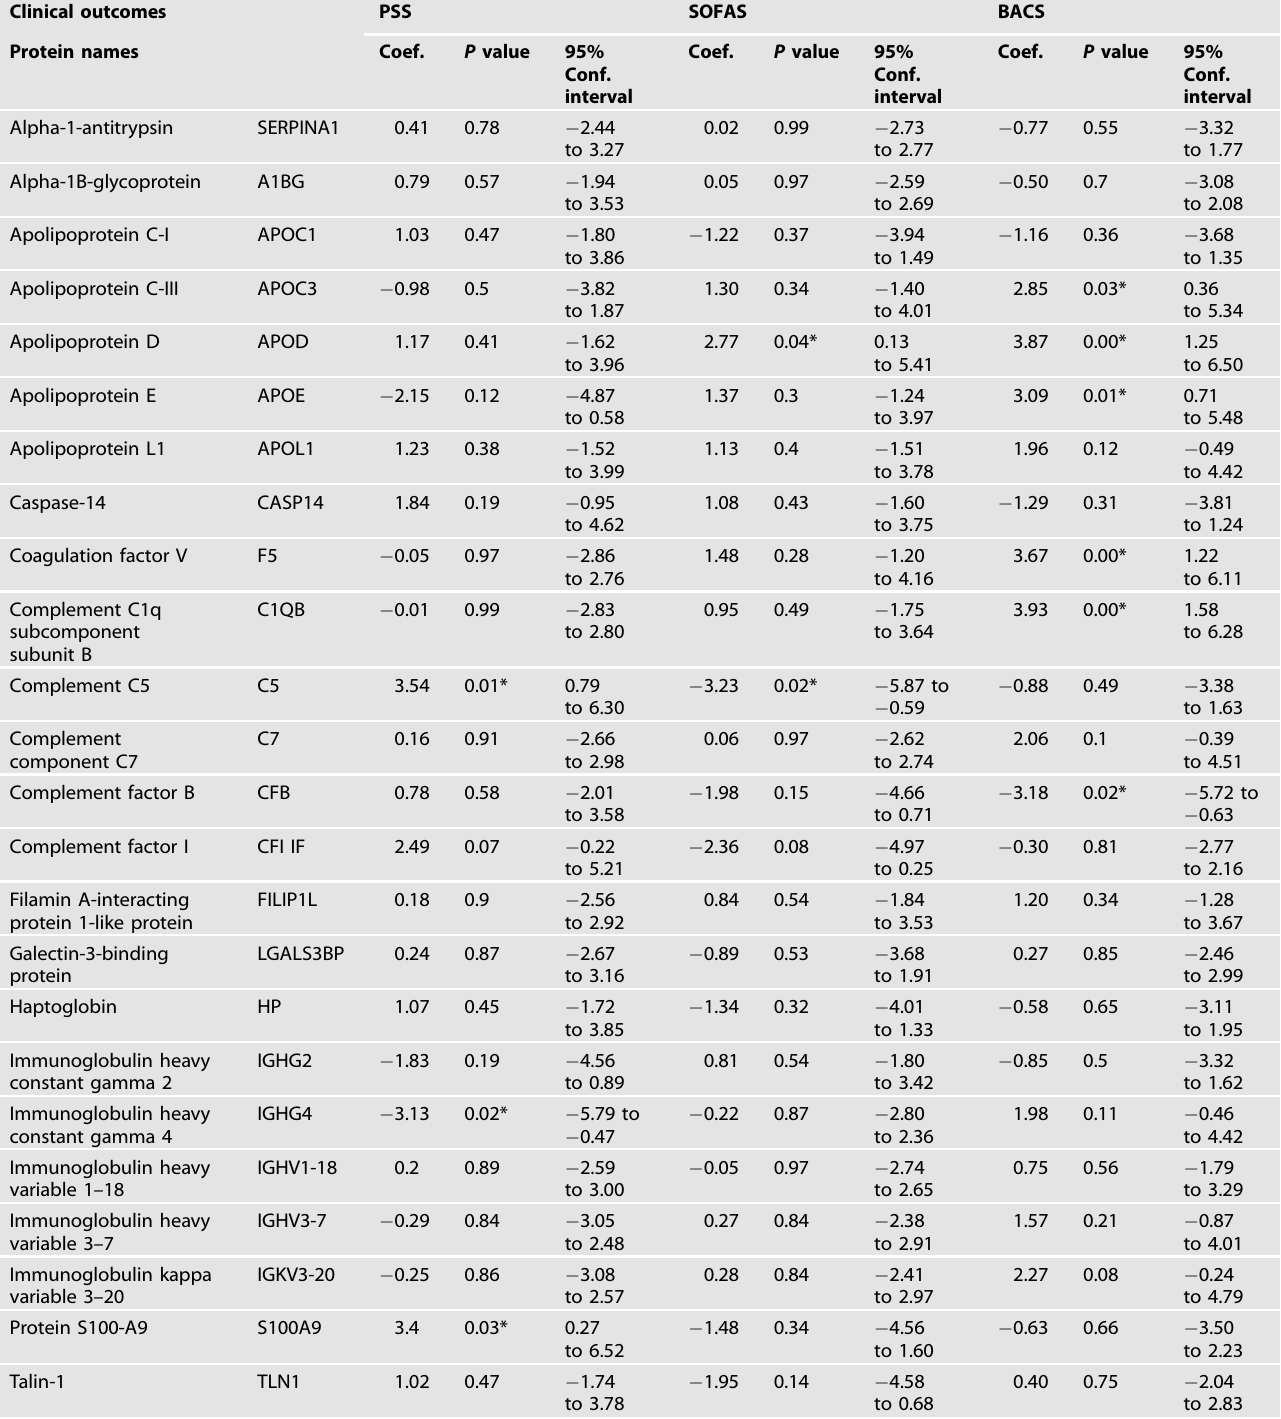
Table 3. Results of linear regression model II, showing a relationship between plasma proteins (which were showing an association with change in omega-3 FAs) with clinical outcomes at 6 months follow-up. Clinical